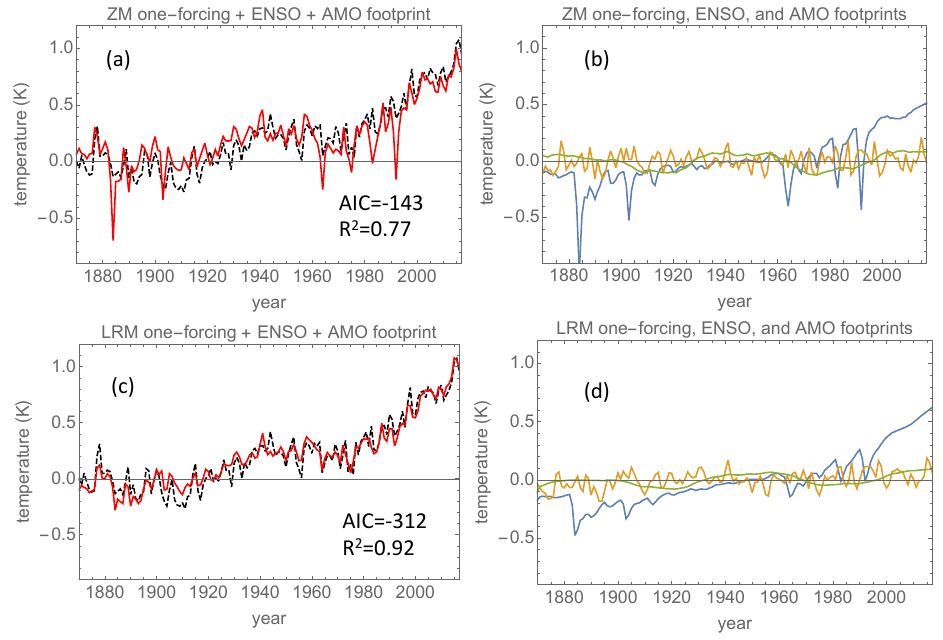
Figure 7. ( a ) The red curve is the total explained GMST (or the total footprint) from the regression when the fingerprints are the unfiltered total forcing and the ENSO and AMO indices. The black, dashed curve is the HadCrut4 GMST signal. ( b ) The individual footprints, whose sum is the red curve in panel ( a ). The blue curve is the total forcing, the yellow curve is the ENSO, and the green curve is the AMO footprints, respectively. Panels ( c , d ) show the results of the same analysis as panels ( a , b ), but with fingerprints filtered with β =